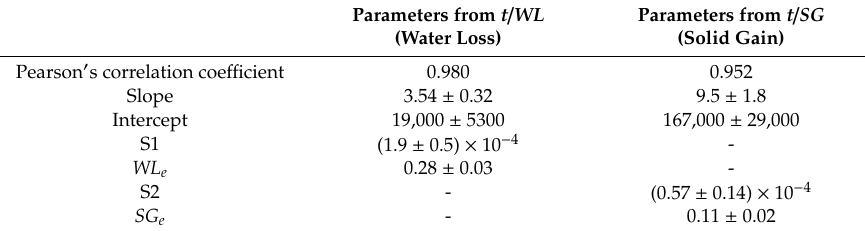
Figure 3. The experimental plots of ( a ) t / WL (blue squares) and t / SG (red circles), ( b ) 𝑙𝑛 ( 𝑊𝐿 𝑒 −𝑊𝐿 𝑡 ) (blue squares) and 𝑙𝑛 ( 𝑆𝐺 𝑒 −𝑆𝐺 𝑡 ) (red circles) as a function of processing time for osmotic dehydration of courgette in the CuSO 4 solution. Error bars represent standard uncertainty. Table 1. The correlation coe ffi cients and equilibrium values for water loss and solid gain during the osmotic dehydration of courgette in CuSO 4 solution estimated from the Azuara model. Parameters from t / WL (Water